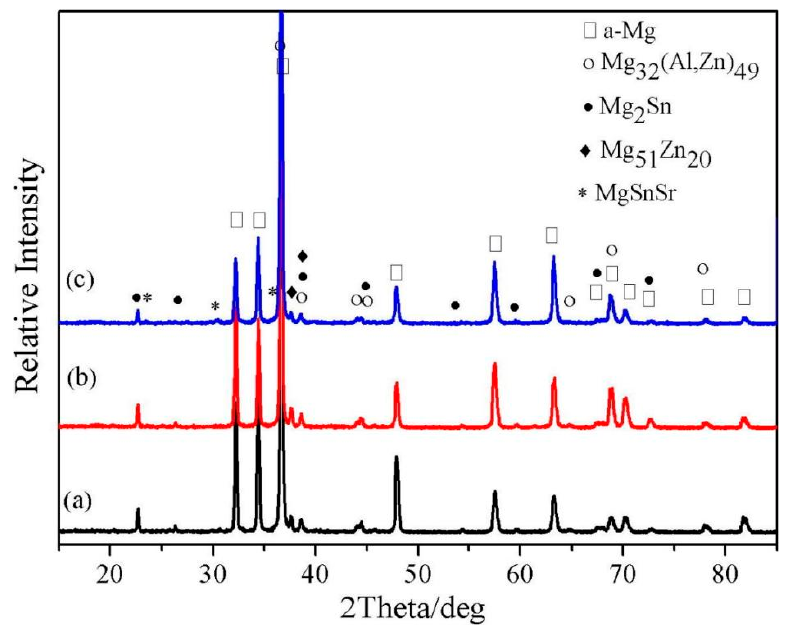
Figure 13. The XRD patterns of as-cast Mg–4.5Zn–4.5Sn–2Al alloys with different Sr additions. ( a ) 0%, ( b ) 0.6% and ( c ) 1.0% [70].